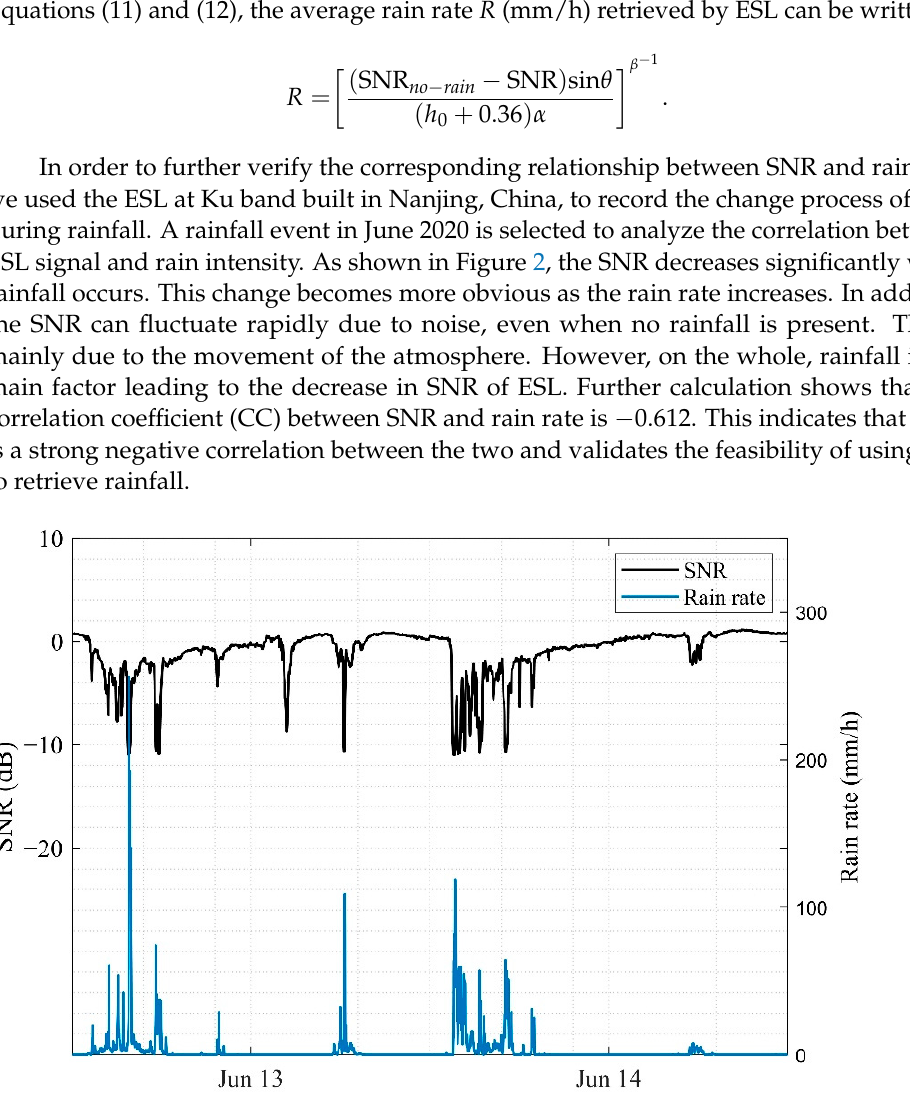
Figure 2. Correspondence between ESL signal and rain rate from 13 June to 14 June 2020. The black line represents the SNR of ESL, and the blue line represents the rain rate.